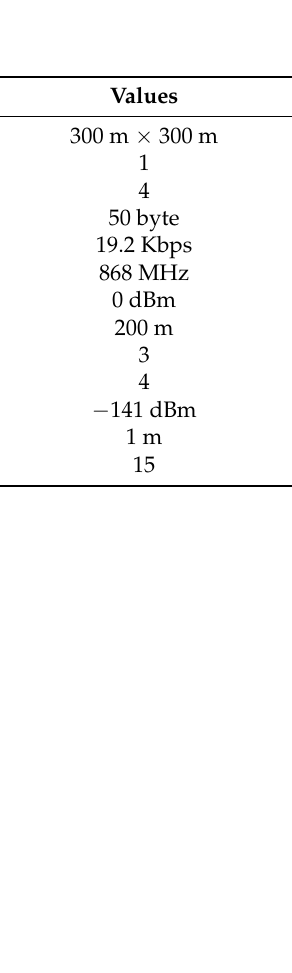
Figure 8. Influence of increasing percentage of mobile nodes on network lifetime.